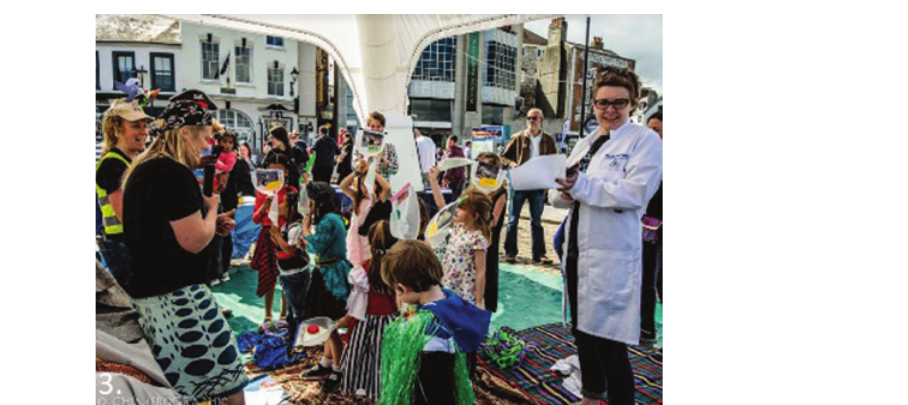
figure 7: M.I.G.h.T.Y – Marine Institute’s Grand handmade Theatrical Yarns (photograph: Ben